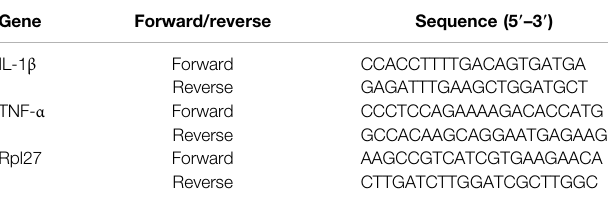
TABLE 1 | Primer sequences of IL-1 β , TNF- α , and